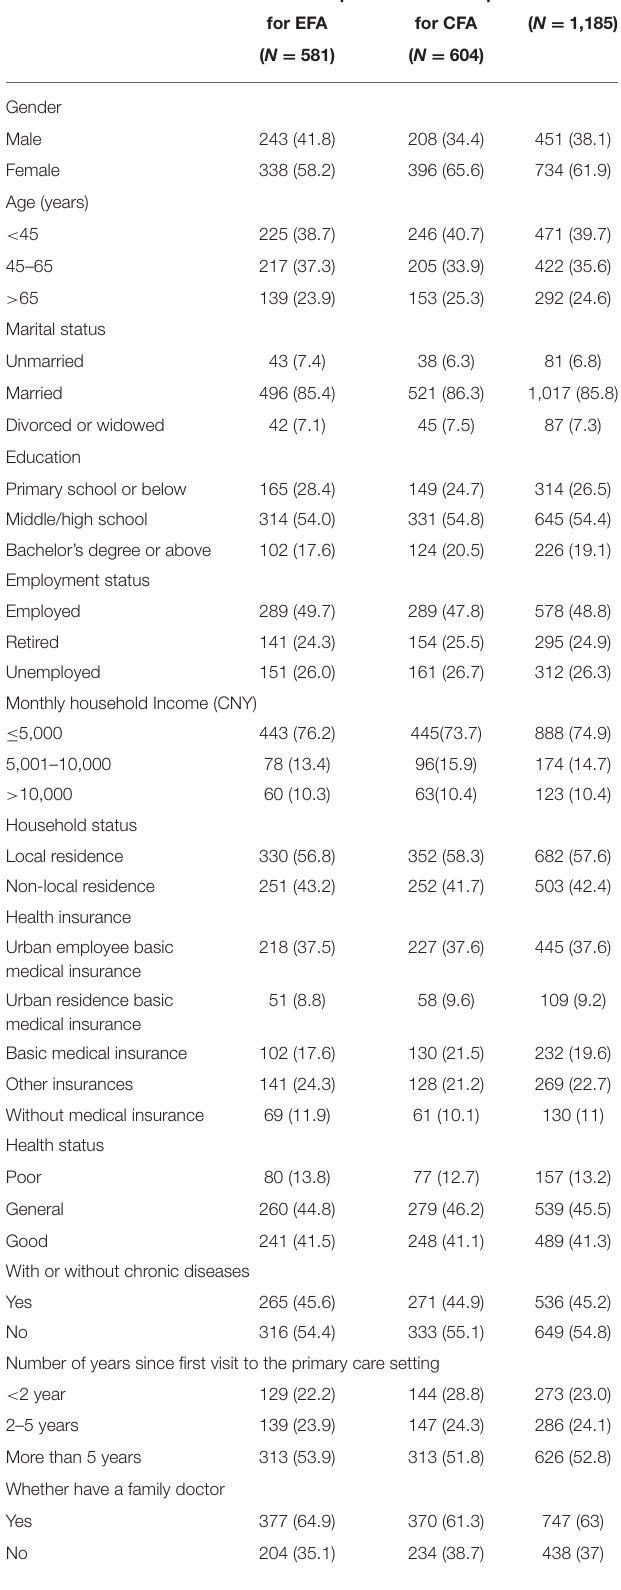
TABLE 1 | Socio-demographic characteristics of the experts participated in selecting items for RA-ASPC ( N = 21).